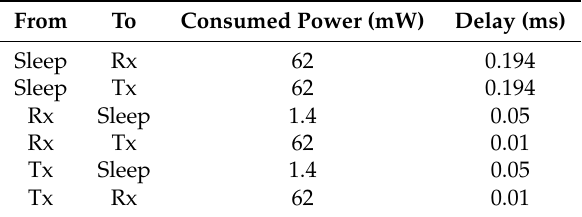
Table 2. The transition delay and power consumption for